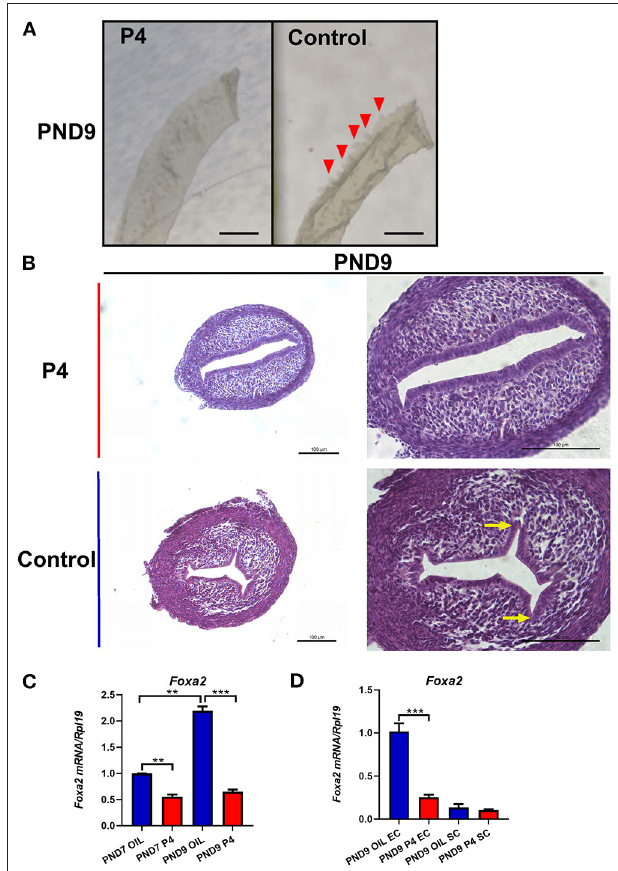
FIGURE 4 | A successful model of endometrial adenogenesis and development loss was established. Representative pictures of endometrial epithelial morphology on PND9 after continuous subcutaneous injection of P4/Sesame oil of neonatal mice, the gland bud of the endometrial cavity indicated by the red triangle, Scale bar, 500 µ m (A) . Hematoxylin and Eosin staining was performed on the uteri on PND9. The gland bud of the endometrial cavity is indicated by the yellow arrow, Scale bar, 100 µ m (B) . The expression of Foxa2 gene in whole uteri on PND7 or PND9 (C) , in epithelium cell (EC), or stroma cell (SC) on PND9 (D) . Results are means ± SEM ( n = 5). Bars with different superscripts are significantly different ( P <